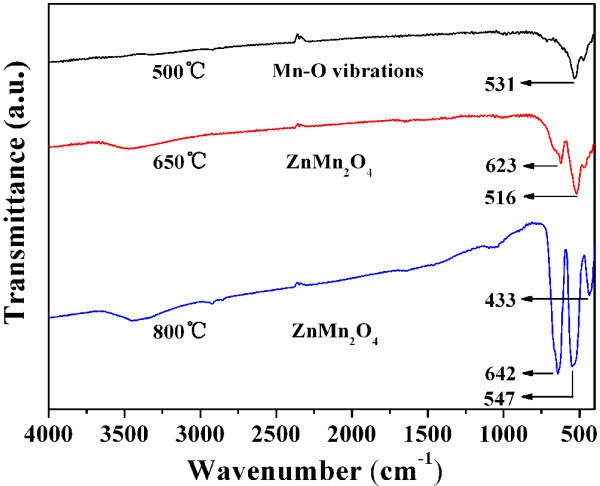
FTIR spectra for the ZnMn2O4 nanorods calcined at 500, 650, and 800°C, respectively.